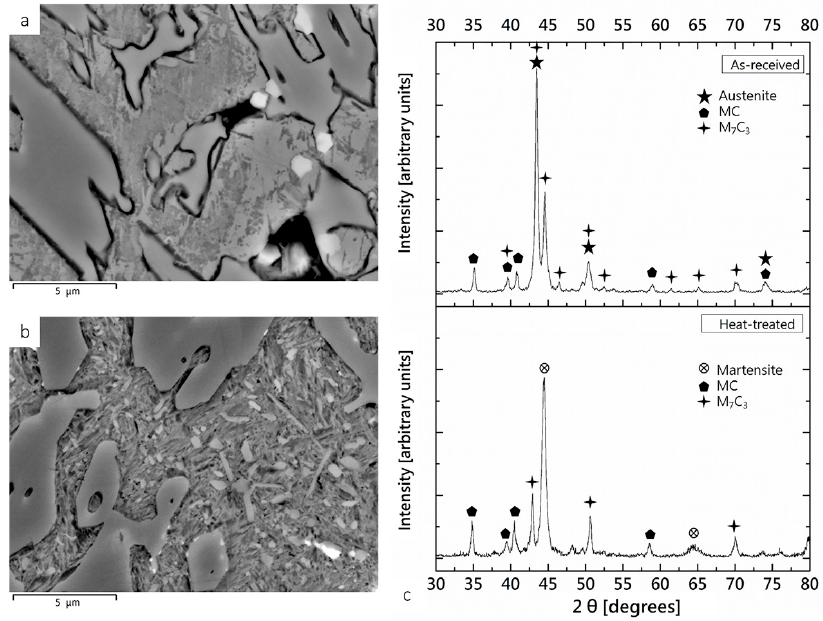
Figure 8. Comparison between as-received and heat-treated conditions. ( a , b ) BSE-SEM images of the hardfacing microstructure: ( a ) as-received and ( b ) heat-treated at 950 °C for 3 h and oil quenched. ( c ) XRD spectra of the as-received and heat-treated conditions.